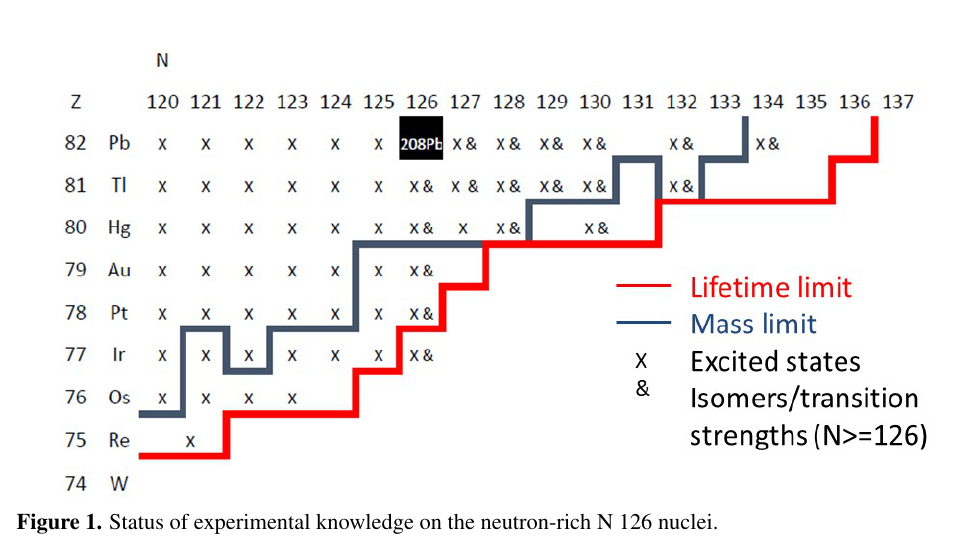
Figure 1. Status of experimental knowledge on the neutron-rich N 126